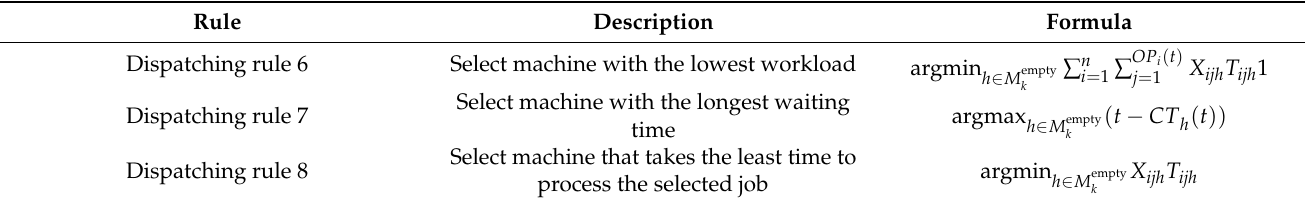
Table 1. Rules for machine